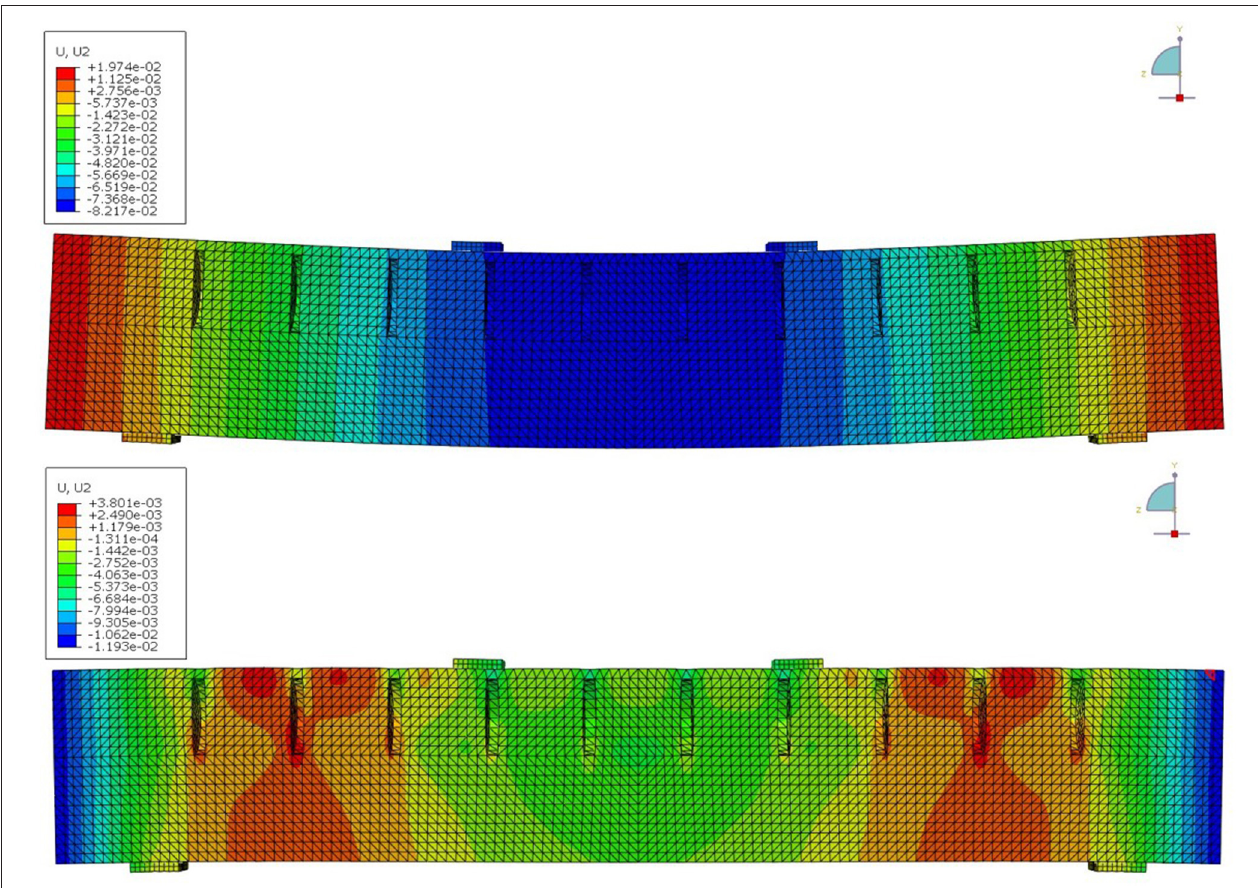
FIGURE 9 | Vertical displacements of the adaptive beam under external load with 0 bar internal pressure (Top) and with 53 bar (Bottom) , up-scaled by a factor of